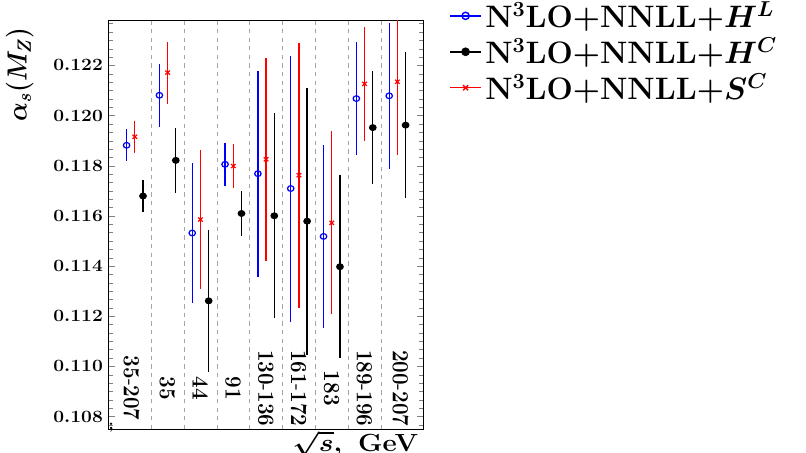
p s of measurement. The (cid:12)t range is [ (cid:0) 2 : 25+ L ; (cid:0) 1].